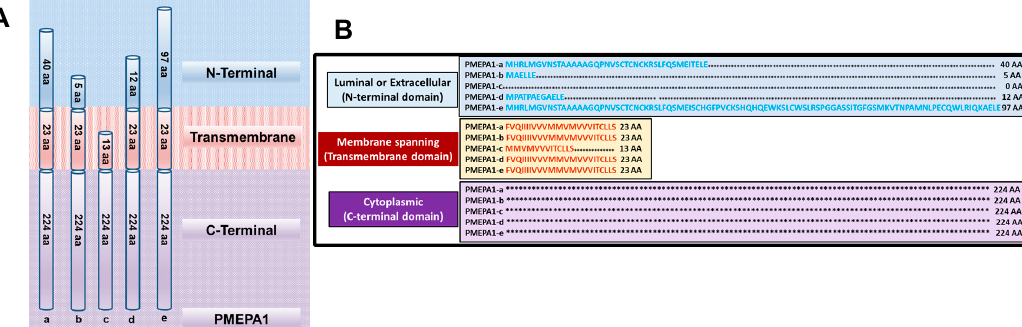
Figure 1. Schematic representation of the predicted domain structure of the isoforms of prostate transmembrane protein androgen induced 1 ( PMEPA1 ) protein. ( A ) Three function domains were predicted with a type 1b membrane protein: N-terminal (luminal/extracellular) (blue), membrane spanning (red) and cytoplasmic (purple). ( B ) Alignment of the predicted domain and amino acid (aa) sequences of PMEPA1 isoforms.